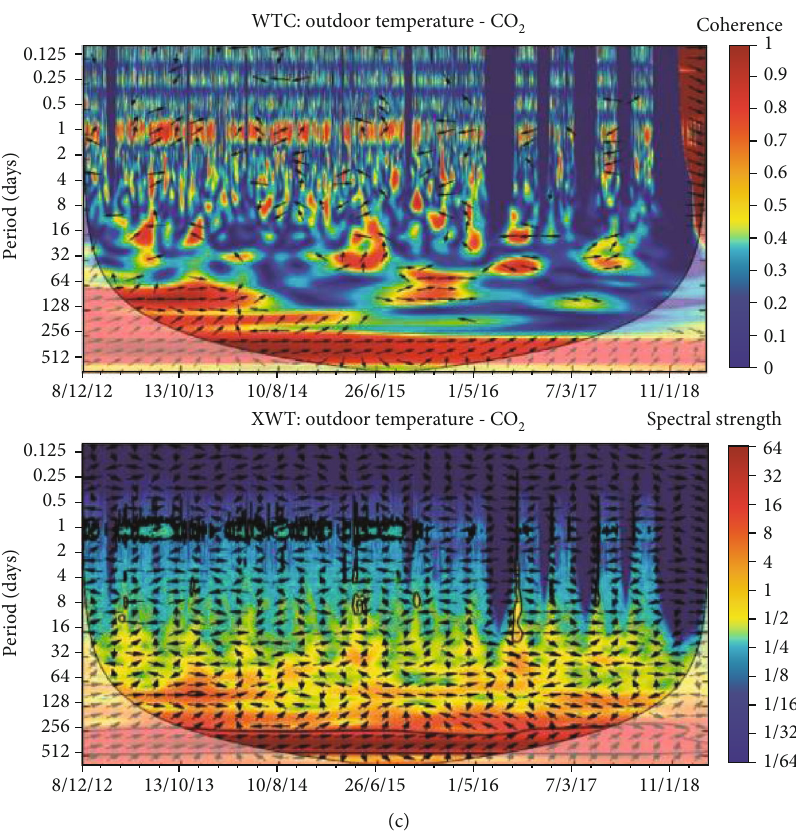
Figure 7: (a) Decomposition of di ff erent periodicities for outdoor temperature, 222 Rn, and CO temperature and 222 Rn. (c) WTC and XWT between outdoor temperature and CO (weak) to red (strong) colors. Arrows indicate the relative phase relationship (inphase pointing right, antiphase pointing left, one signal leading the other by 90 ° pointing up/down). Curved lines on scalograms indicate the cone of in fl uence where the edge e ff ects are important.